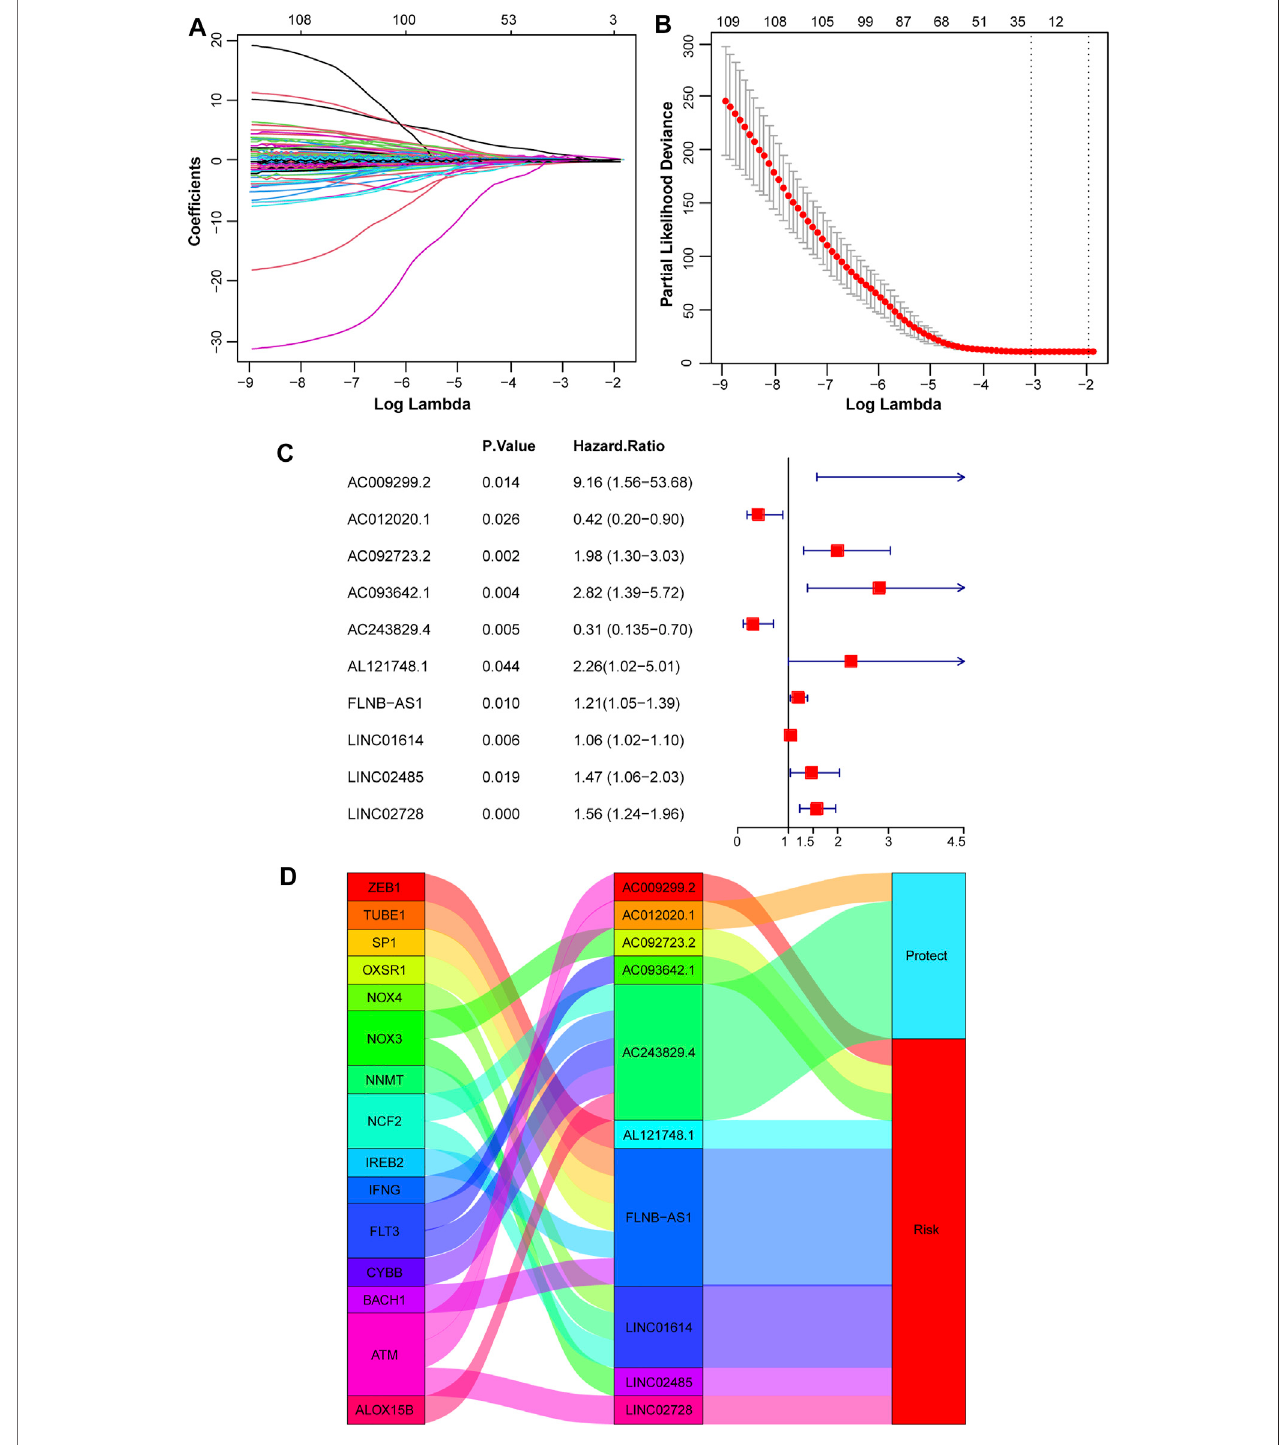
FIGURE2| Constructionofaprognosticmodelbasedonferroptosis-relatedlncRNAs. (A,B) Variablecoef fi cientsandthepartiallikelihooddevianceunderdifferent lambdaintheLassoanalysis. (C) 10independentprognosticlncRNAswerefound via theMultiCoxregressionanalysis. (D) ASankeydiagramshowedtherelationshipof ferroptosis-related genes, screened 10 lncRNAs, and protect or risk roles in OS.